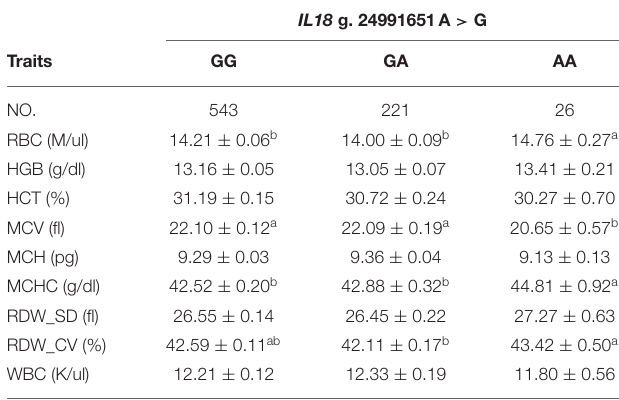
TABLE 4 | Association analysis between polymorphism of IL18 gene and hematologic traits of Hu